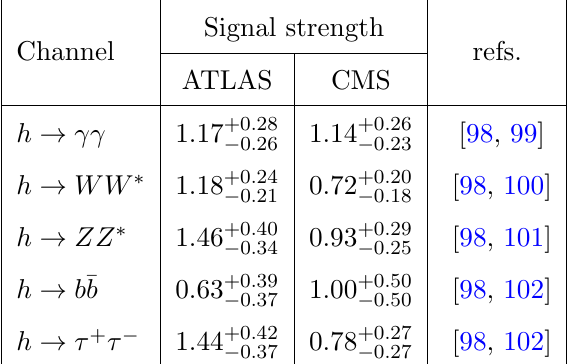
Table 1 . Experimental results of Higgs signal strength measurements in various channels that are used in the HiggsSignals analysis